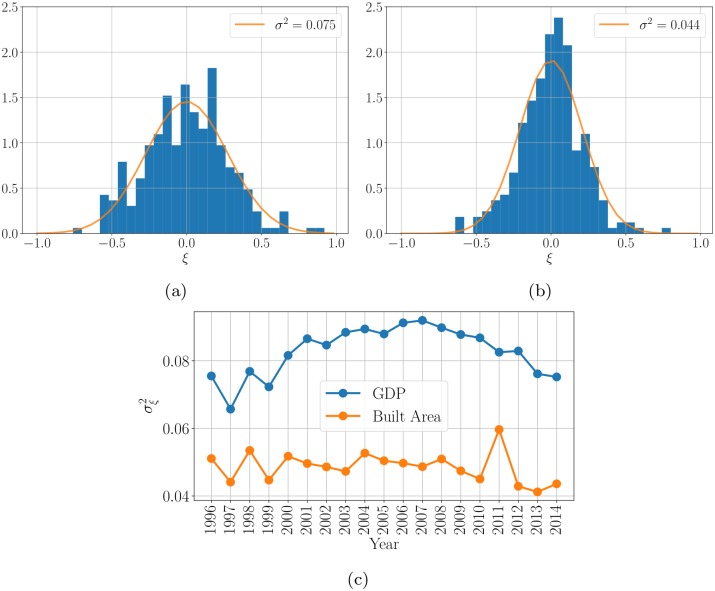
Histograms showing the frequency distribution of the residuals for the Gross Domestic Product of Prefecture-level cities (a) and their built up surface area (b) in the year 2014. The distributions can be roughly described by a Normal distribution (orange line). (c) depicts the temporal evolution of the variance σ2 from the respective distribution of the residuals. The distribution of residuals has a relatively large variance σ2 compared to other urban systems.